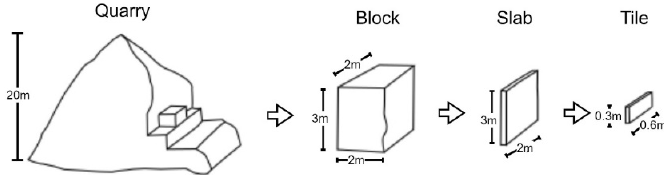
Figure 1. Schematic representation of marble processing from quarry to tile.